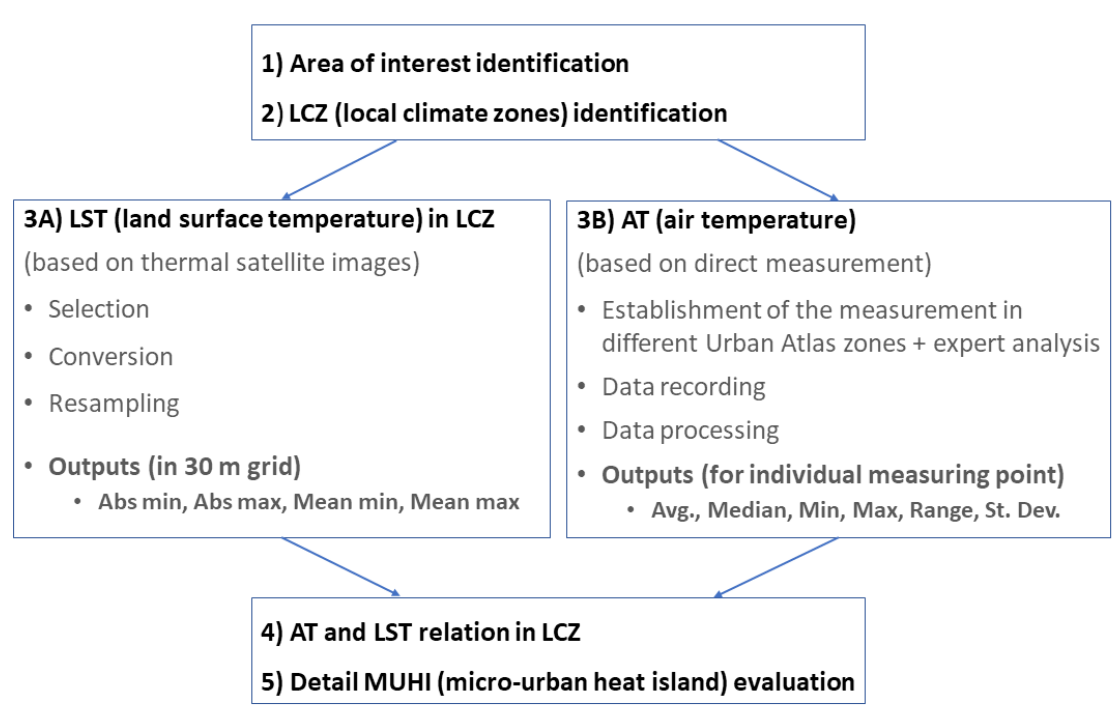
Figure 1. The methodological flowchart.